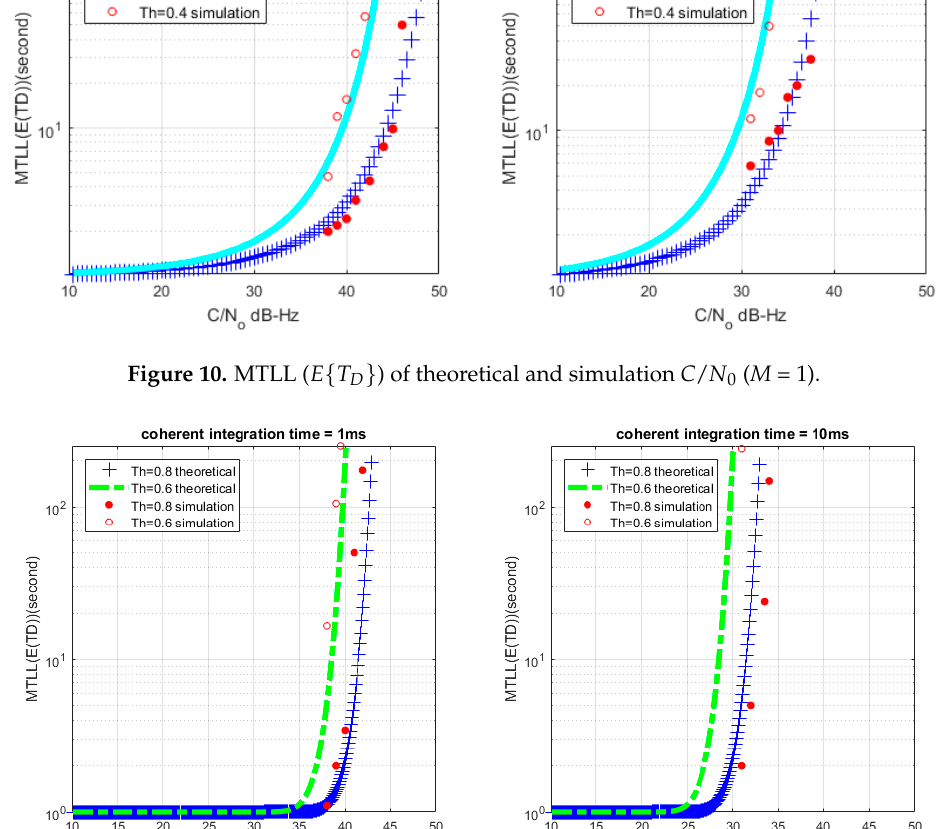
Figure 11. MTLL ( { } D E T ) of theoretical and simulation C / N 0 ( M = 20).